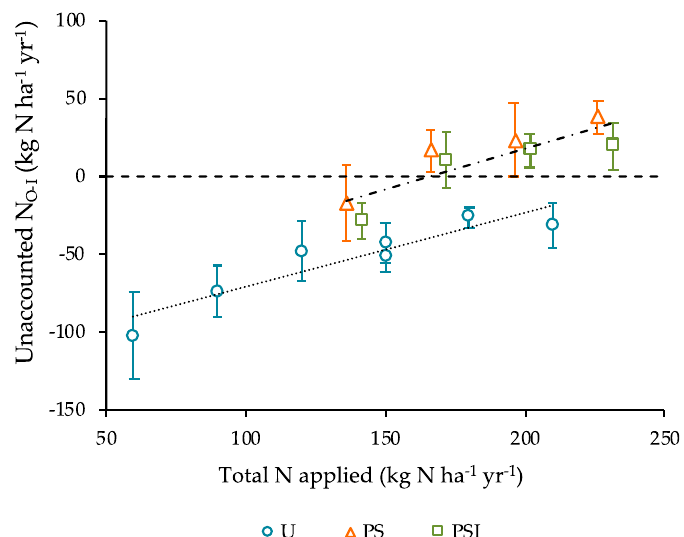
Figure 5. Relationship between the unaccounted N O-I (kg N ha − 1 yr − 1 ) obtained from the 0–90 cm soil N balance and the total N applied (kg N ha − 1 yr − 1 ) for the whole experimental period. Vertical bars indicate the experimental standard error ( n = 4).